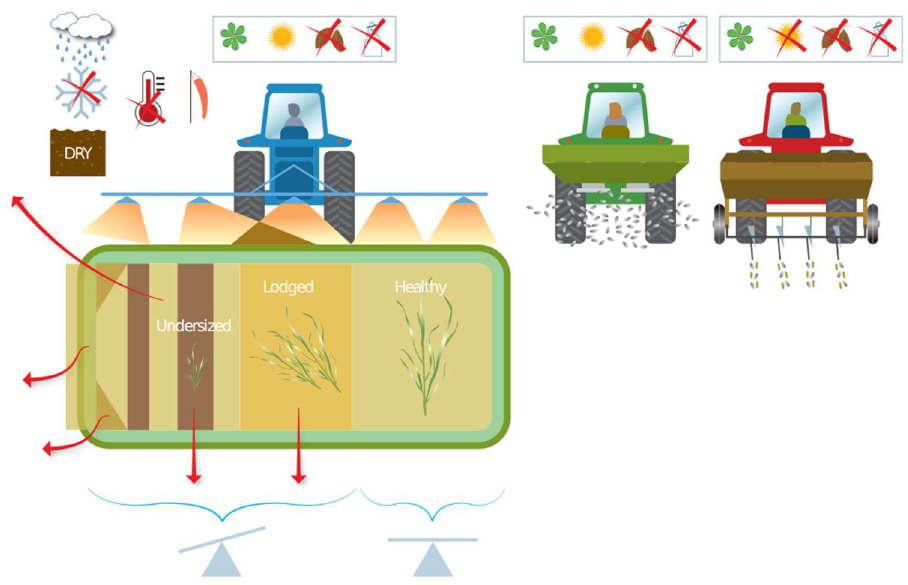
Figure 2. Causes of reduced NUE at the inputs stage due to application management. Icons show rain, frozen ground, dry soil, high temperatures, low wind, relevant to temperate climate (spring, summer, autumn, and winter), and balance (calibration) of application.